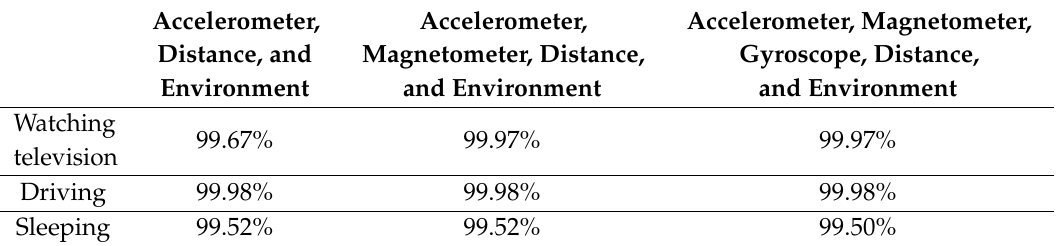
Table 18. Accuracies of the activities’ recognition without motion using the AdaBoost with the decision tree implemented with the SMILE framework for motion, magnetic, and location sensors after the recognition of the